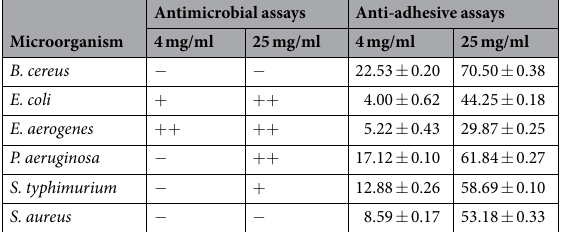
Table 4. Antimicrobial and anti-adhesive activities of the BS derived from P. dextrinicus SHU1593. “ + ” sign shows inhibition of microbial growth, whereas “ − ” sign means an inability to inhibit the growth of the examined microorganisms. Values of anti-adhesive assays are representatives of mean ± S.D. (n = 3).